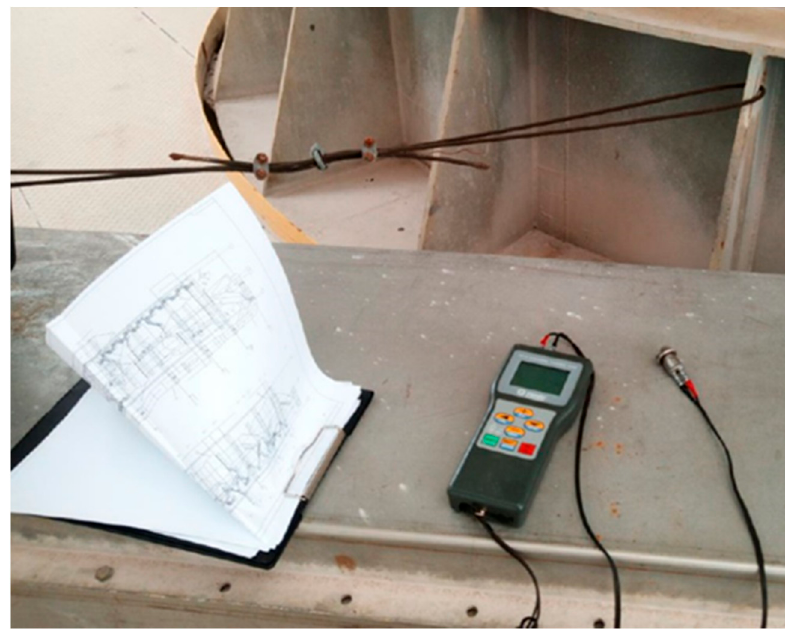
Figure 7. Ultrasonic thickness measurements.